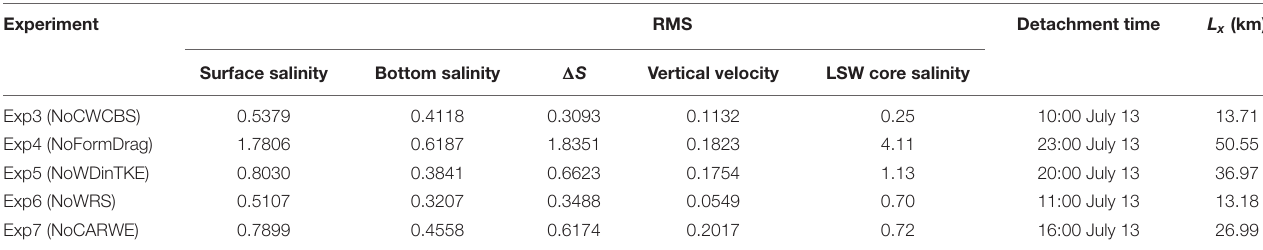
TABLE 2 | The root mean square (RMS) of the difference between the control run and each experiment on surface salinity, bottom salinity, (cid:49) S , vertical velocity, and low-salinity water (LSW) core salinity, and the detachment time and L x calculated by Equation (13) in each experiment. Experiment RMS Detachment time L x (km) Surface salinity Bottom salinity (cid:49) S Vertical velocity LSW core